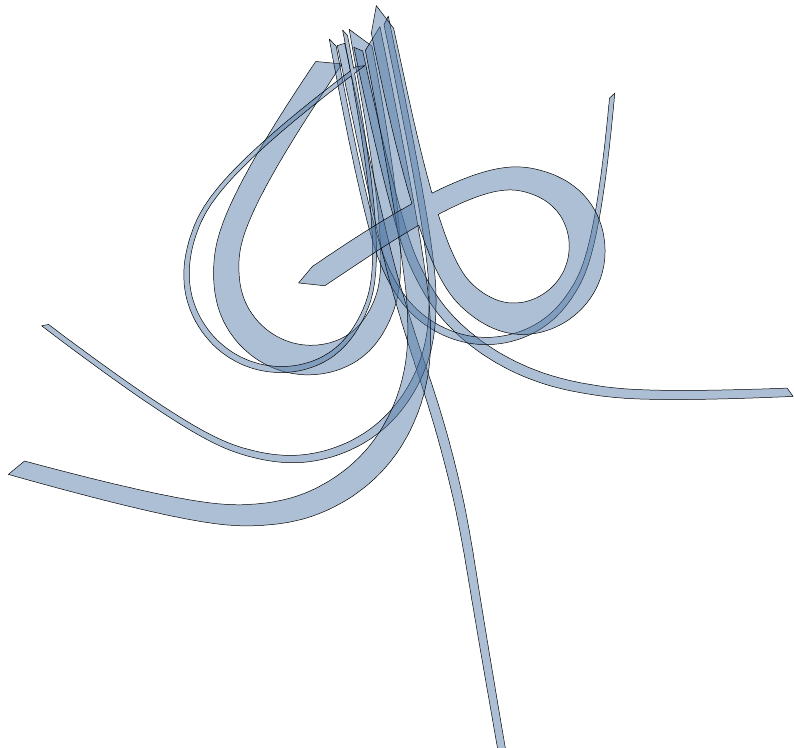
Figure 32. Homography sculpture, unrolled